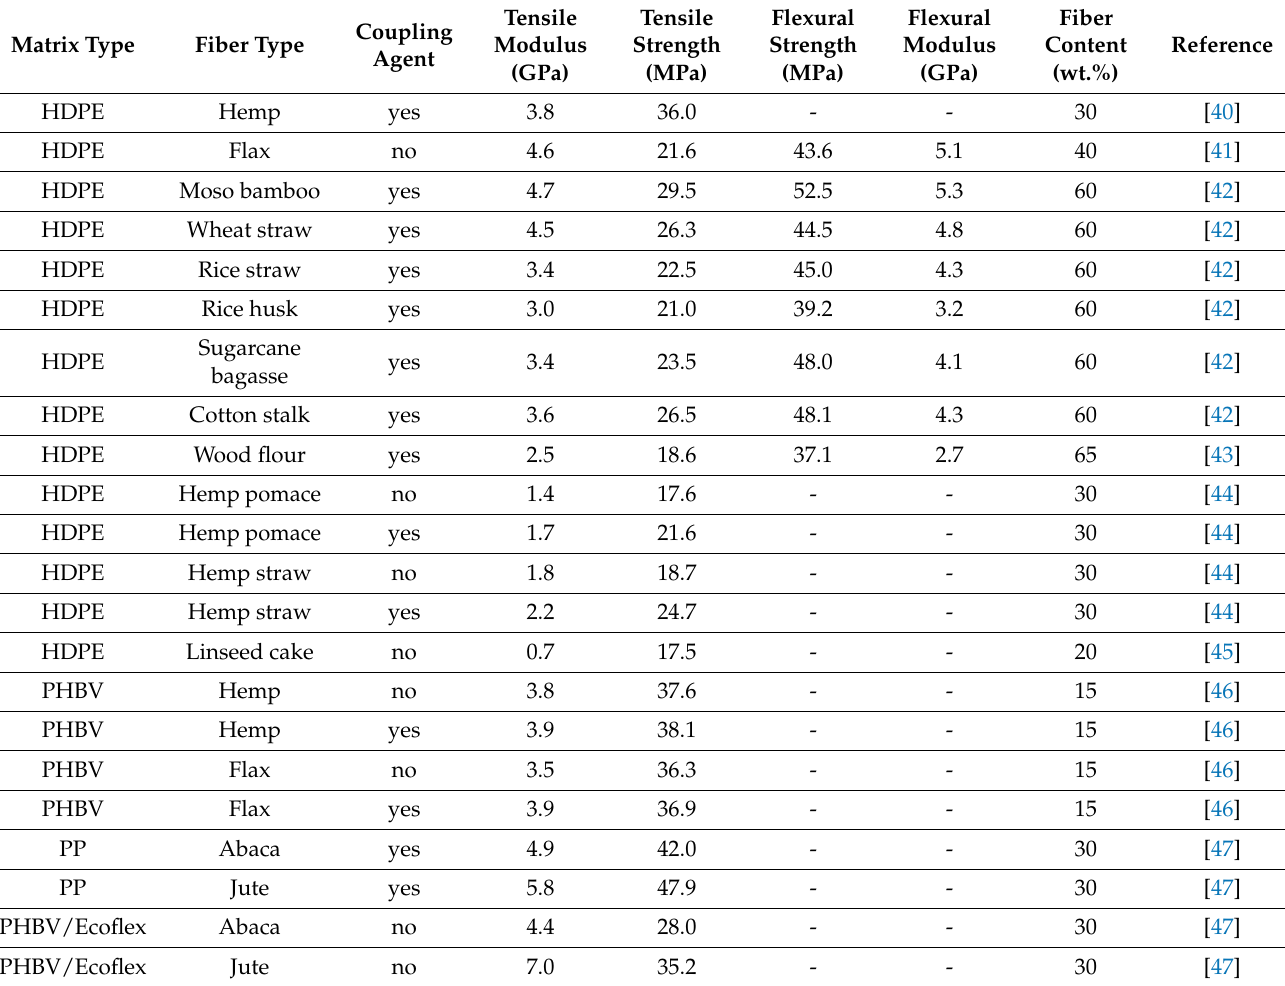
Table 4. Summary of mechanical properties of polymer matrix composites reinforced with lignocellu- losic